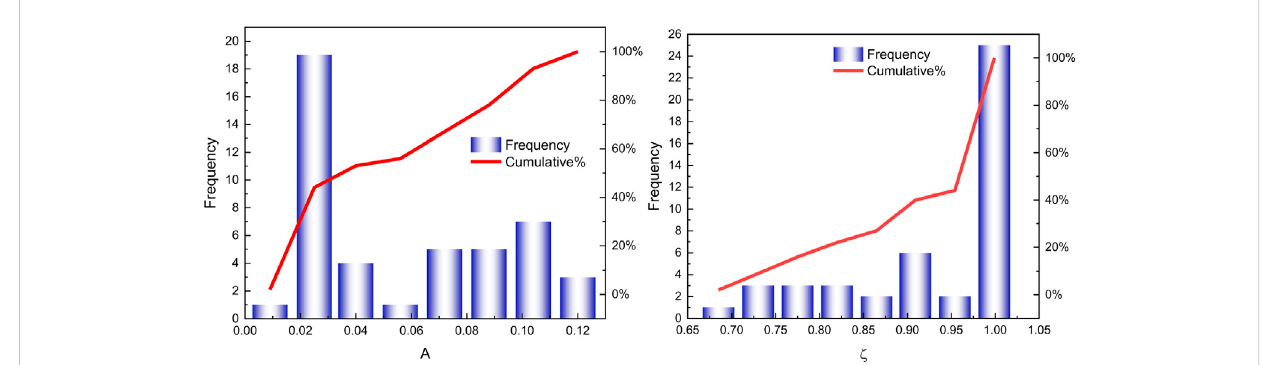
FIGURE 4 Histograms and CDFs of A and ζ values for the straight-tube model obtained from curve fi tting.